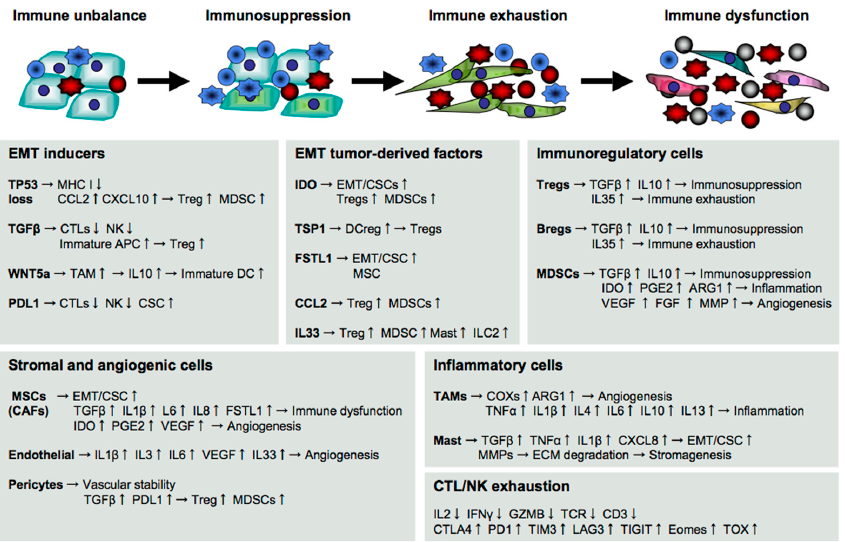
Figure 2. Immune determinants driving cancer metastasis. Cancer metastasis is induced and facilitated by numerous immunological components in the host. The EMT-induced tumor cells produce numerous cytokines and chemokines to induce immune suppression, exhaustion, and dysfunction sequentially toward a successful escape.